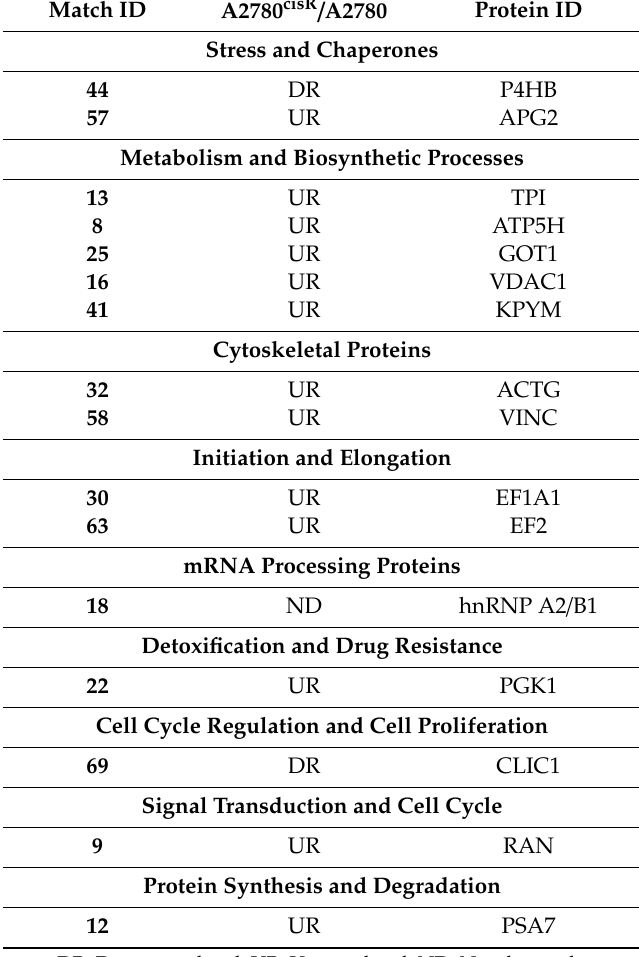
Table 11. Functional classification of the proteins that are di ff erentially expressed in the A2780 cisR cell line compared to the A2780 cell line due to treatment using the A2780 cisR cell line as